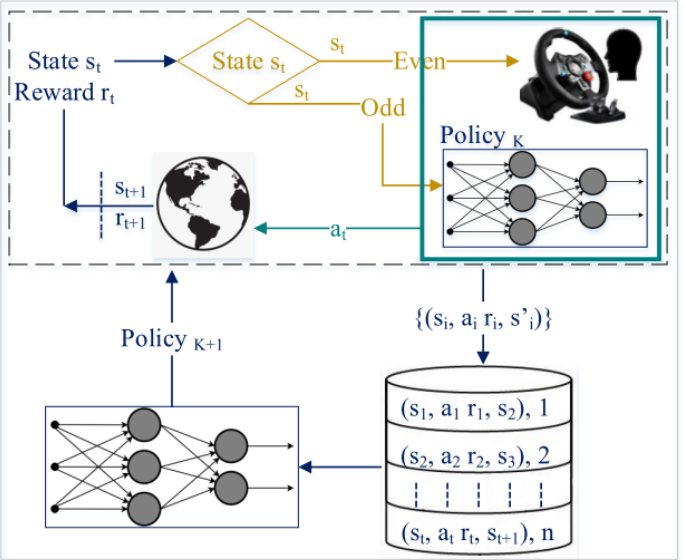
Figure 1. Schematic illustration of our procedure for obtaining human expert demonstration